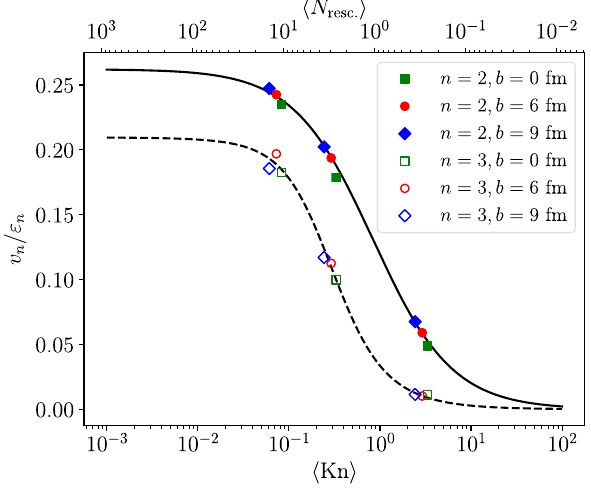
Fig. 2 Elliptic flow v 2 and triangular flow v 3 , divided by the corre- sponding eccentricity, as a function of the average Knudsen number for simulations with the different cross sections used in this paper. The curves correspond to fits with Eq. (11) (full curve) resp. (12) (dashed